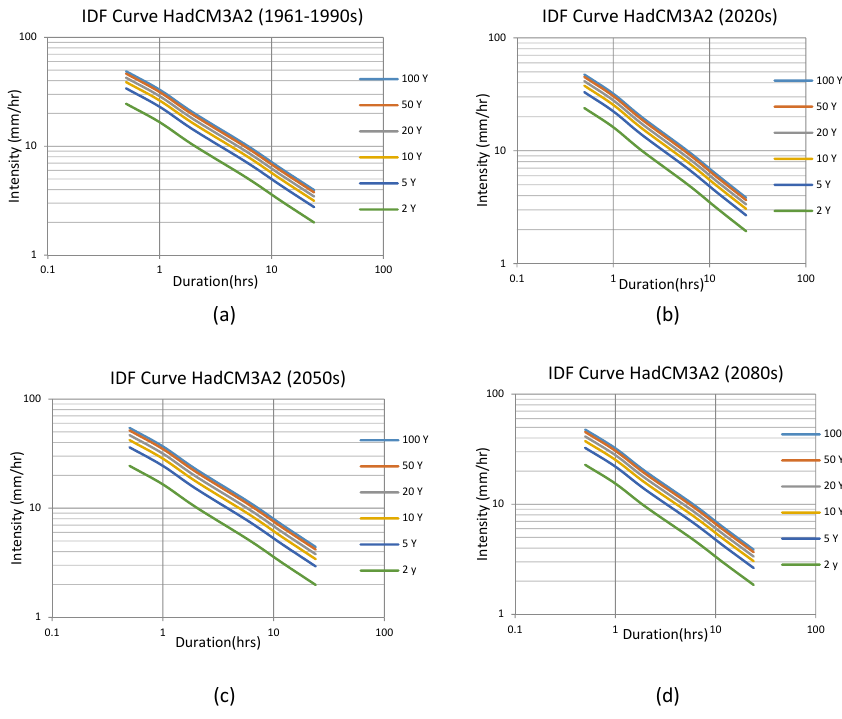
Figure 5. Developed IDF curves for Canberra Airport